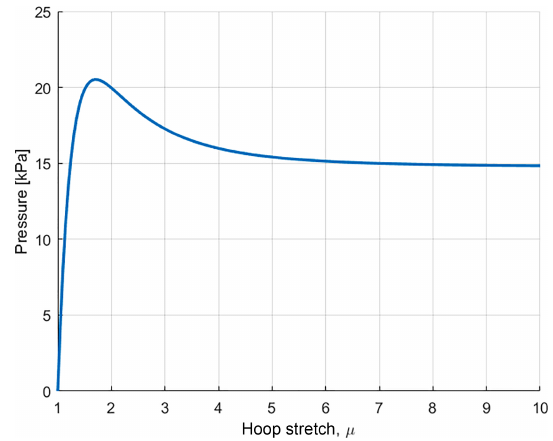
Figure 4. The plot of p = p ( µ ) for an extendable balloon.